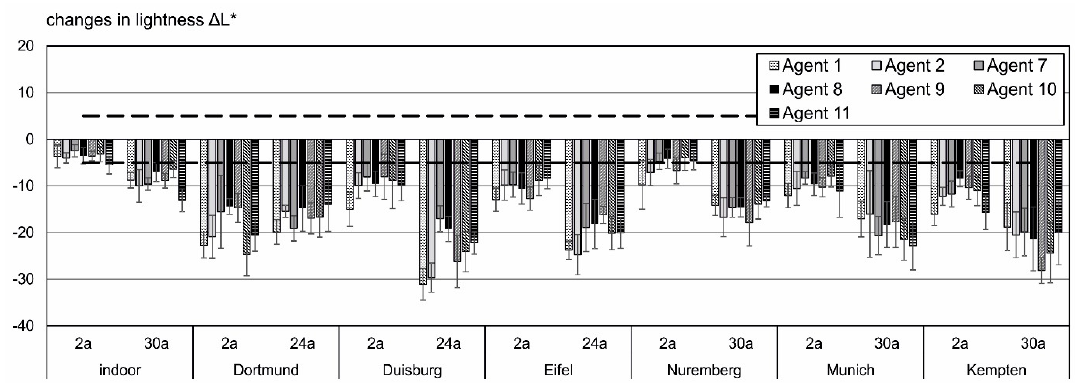
Figure 6. Δ L* values of OKS samples, treated with silanes (agent 1, 2), siloxanes (agent 7, 9, 10) and silicone resins (agent 8, 11) from different exposition sites.